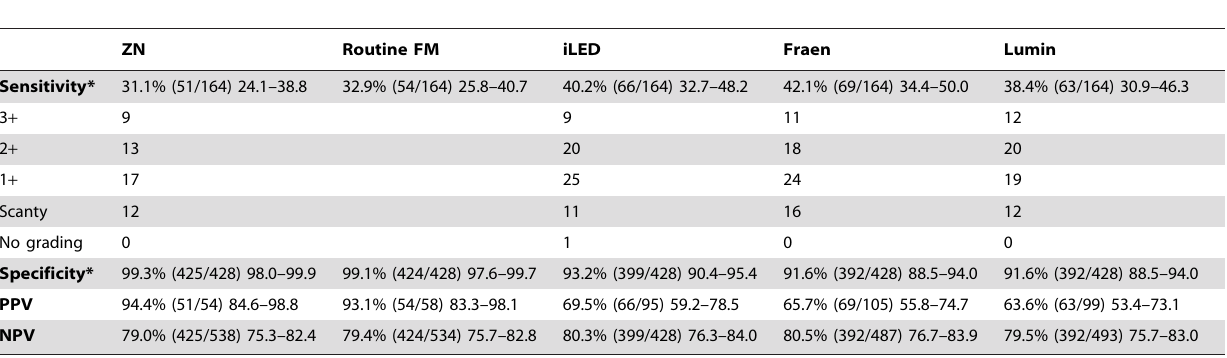
Table 1. Performance of three LED-based fluorescence microscopy devices in detection of tuberculosis in HIV-positive suspects in Kampala, Uganda, per specimen analysis.